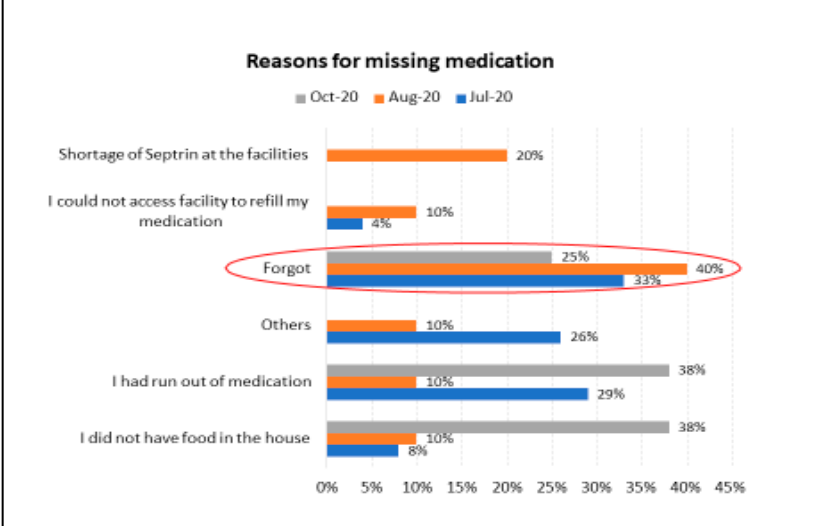
Figure 1. Reasons for missing ART medication .